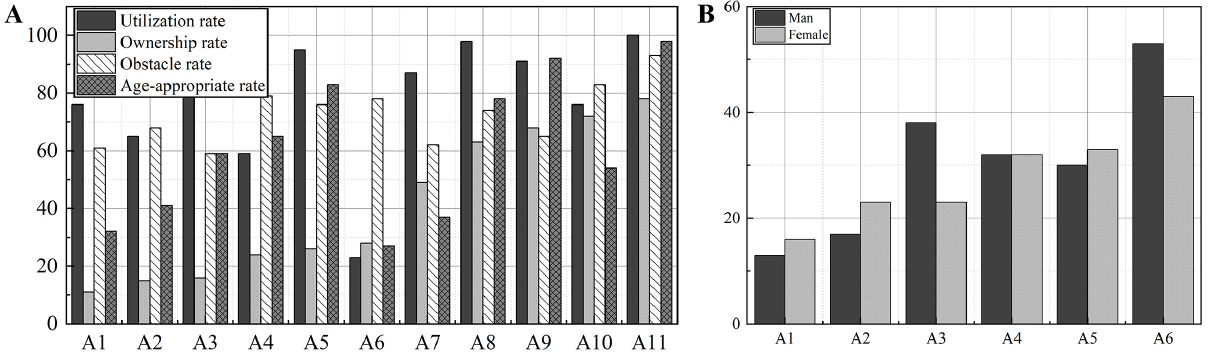
Figure 1. Statistics on the use of household appliances by ‘self-care’ elderly individuals. ( A ) is the ‘usage table’ of the living room furniture, ( B ) is the demand analysis of chairs and stool furniture for the elderly. A1: book and newspaper rack, A2: shoe changing stool, A3: bucket, A4: recliner,